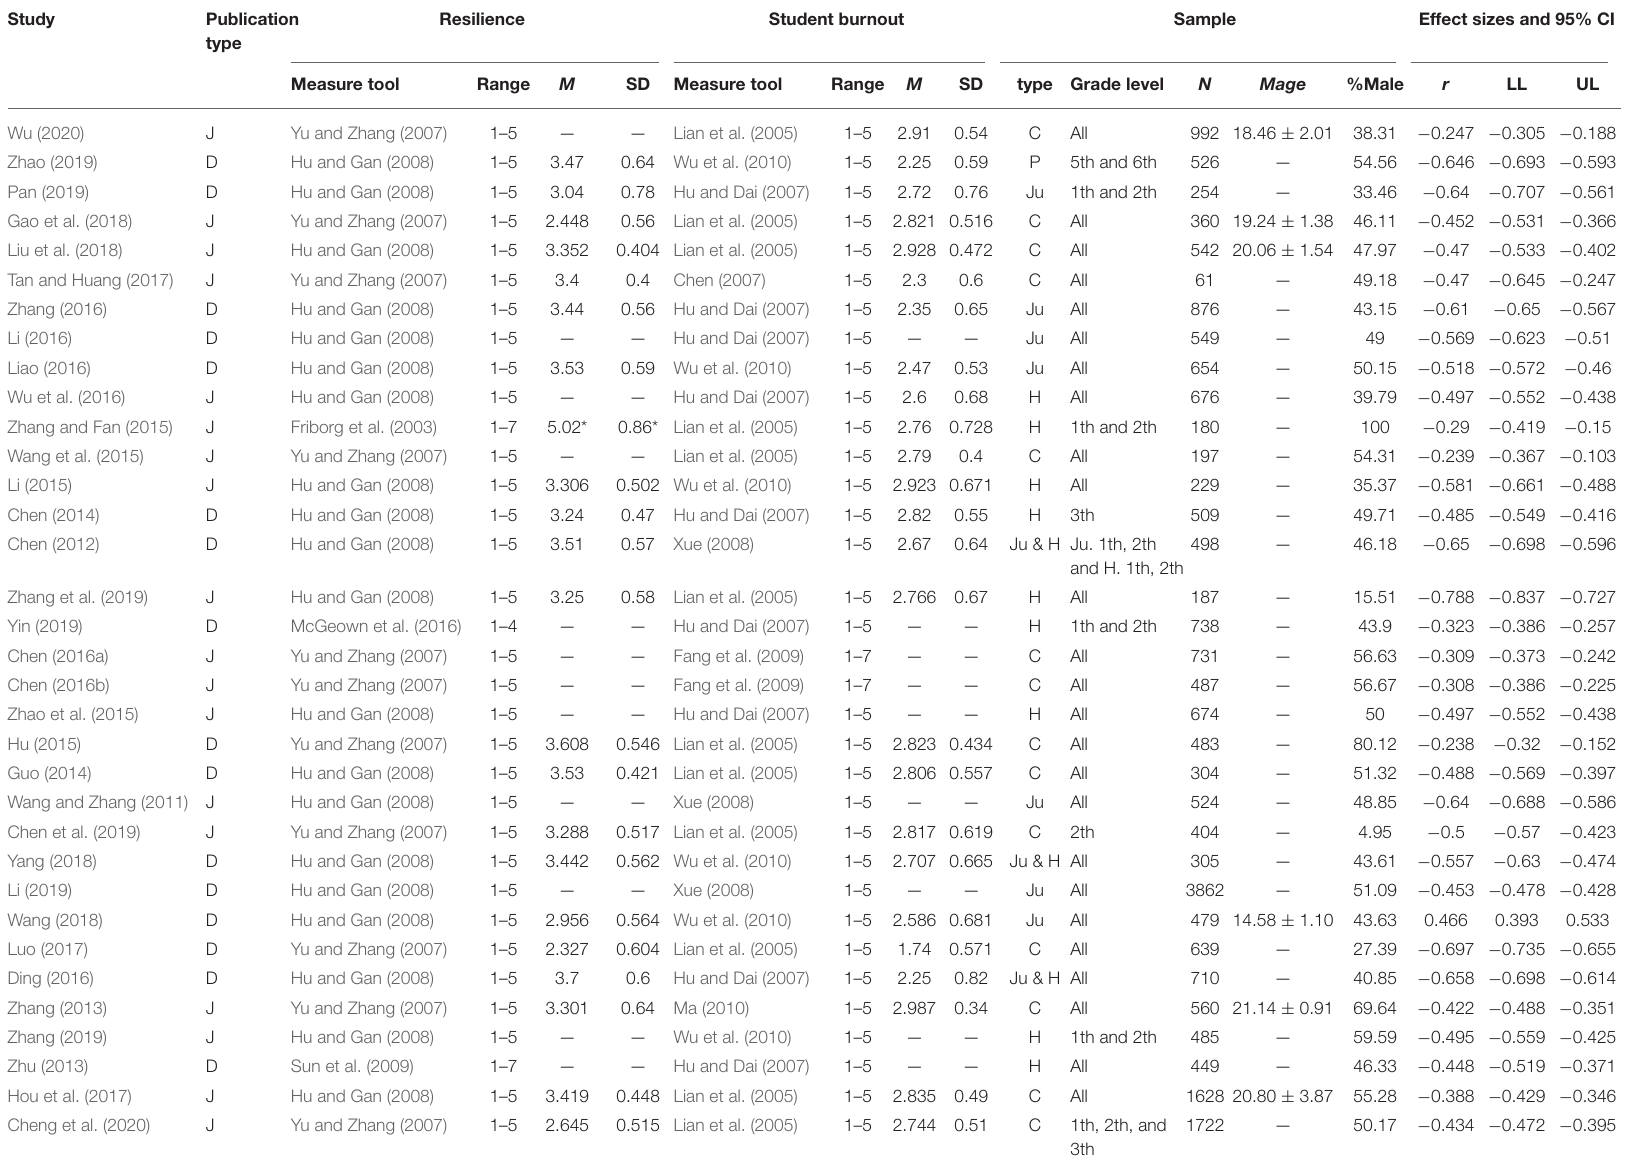
TABLE 1 | Studies included in the meta-analysis ( k = 34, n =